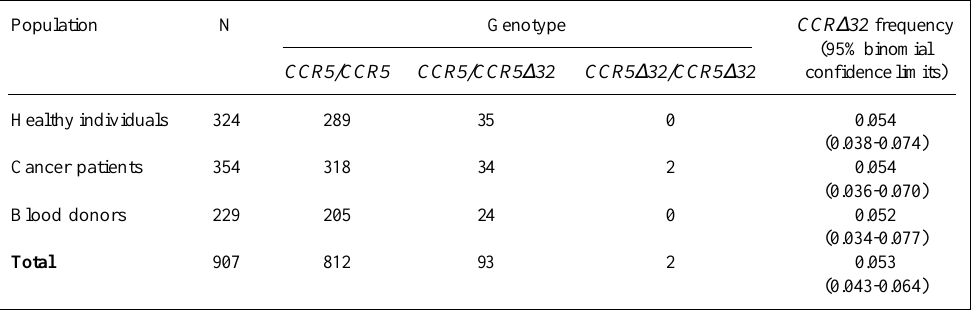
Table I - Determination of the CCR5 ∆ 32 allele frequency in the urban population of southeastern